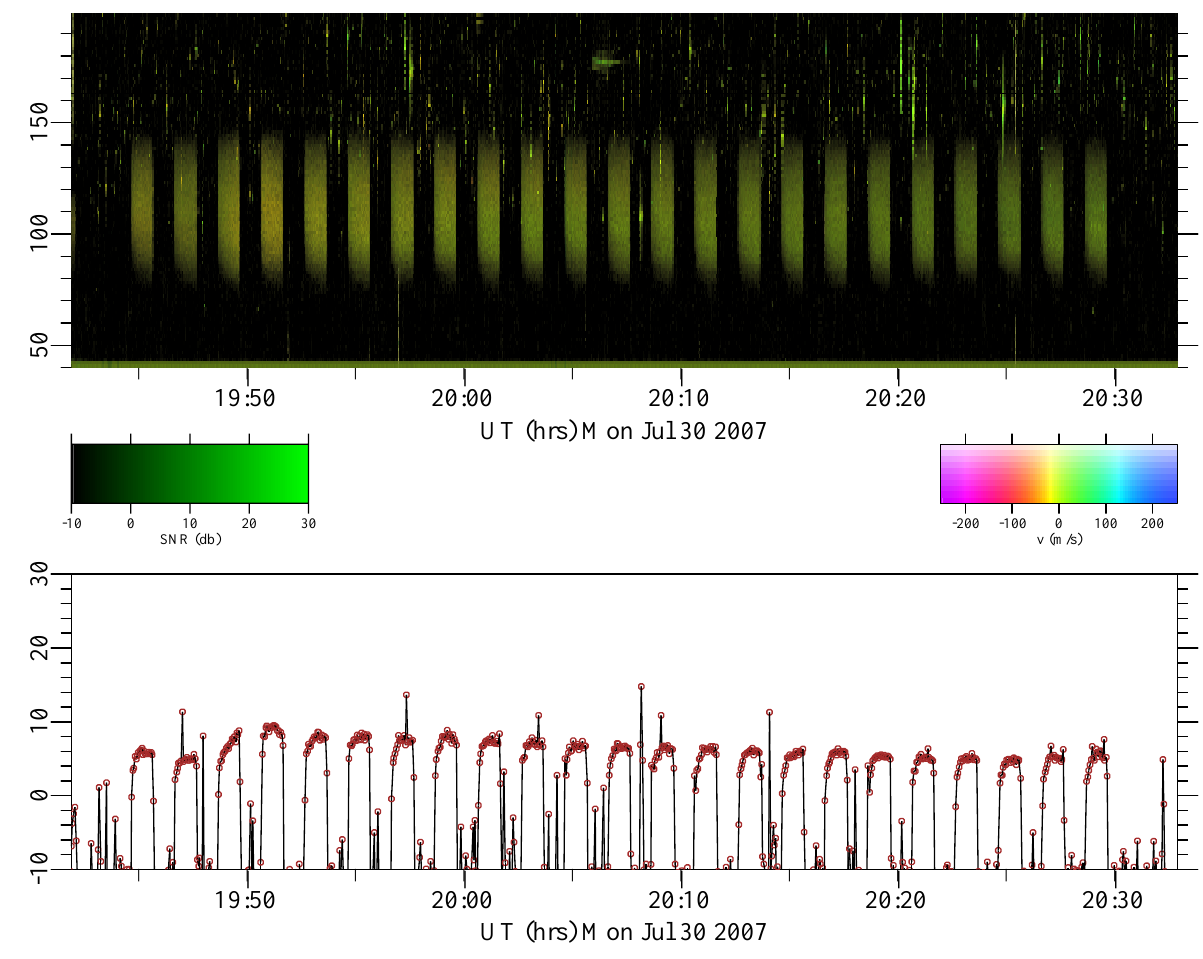
Fig. 3. RTDI plot of backscatter from artificial E region FAIs over HAARP observed on July 30, 2007. Note that the echoes from heater- induced FAIs are range aliased and that their true range is greater than their apparent range by 370 km. The signal-to-noise ratio for apparent ranges between 90–130 km is plotted beneath the RTDI plot. Note also the tendency for meteor echoes to obscure artificial E region FAIs.